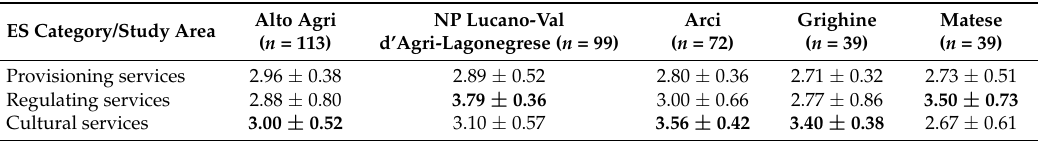
Table 2. Stakeholders’ preferences for three ES categories by study area (mean